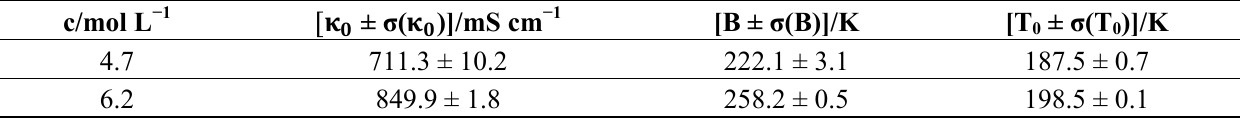
Table 3. VFT-fitting parameter of temperature dependent conductivities (also see Figure 3); σ is the standard error of the fitting